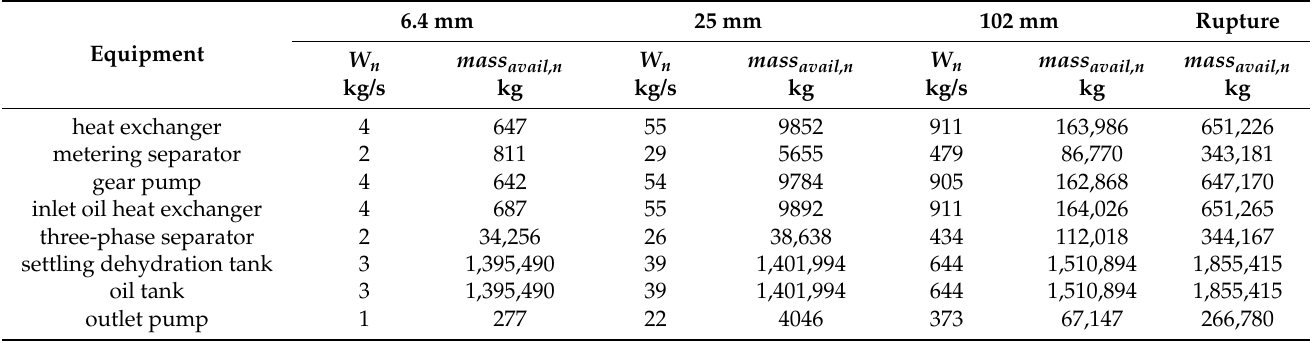
Table 7. Leakage rate and total leakage of equipment.